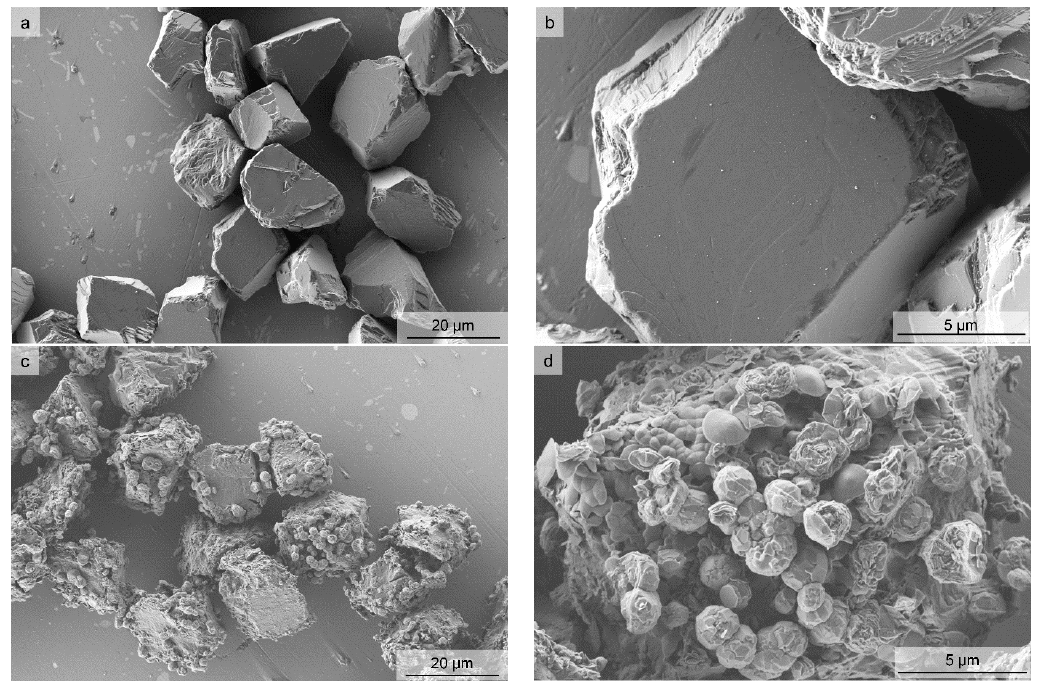
Figure 1 . FESEM micrographs of the initial ( a , b ) and the prior oxidized ( c , d ) cubic boron nitride (c-BN) powders after heat treatment at 1550 °C in Ar.